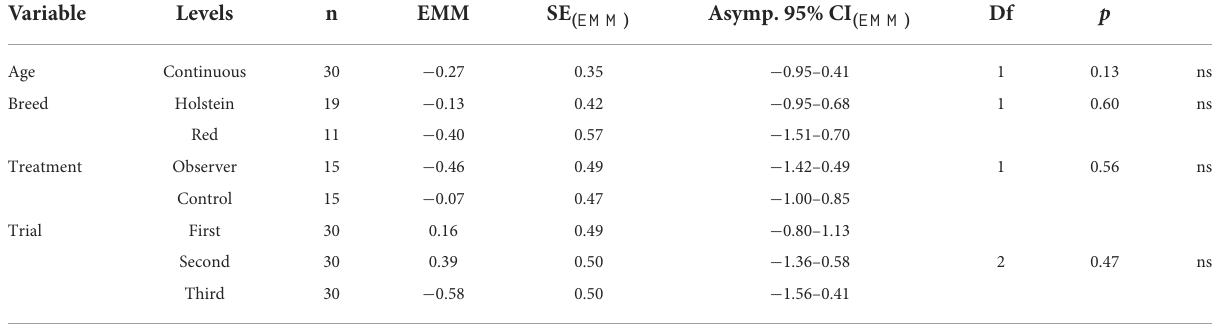
TABLE 2 Summary of the mixed-effects logistic regression on success of solving detour task through use of demonstration route. Variable